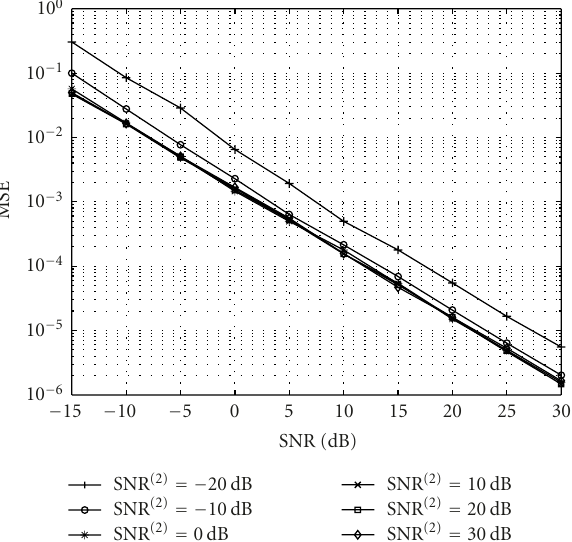
Figure 3: The MSE of the estimated channel versus SNR at the first antenna for di ff erent values of SNR at the second antenna. The WP algorithm.